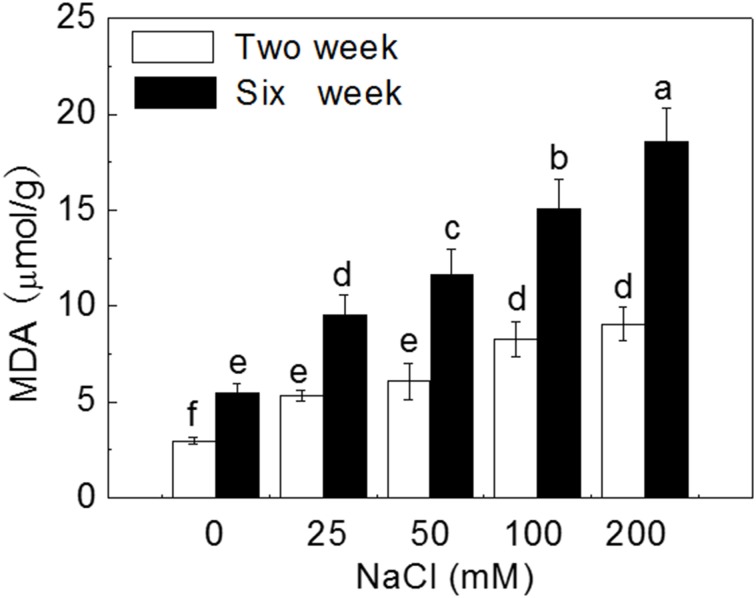
Effects of NaCl treatment on malondialdehyde (MDA) content. Values are means and bars indicate SDs (n = 6). Columns with different letters indicate significant difference by Duncan's multiple range tests at P < 0.05.